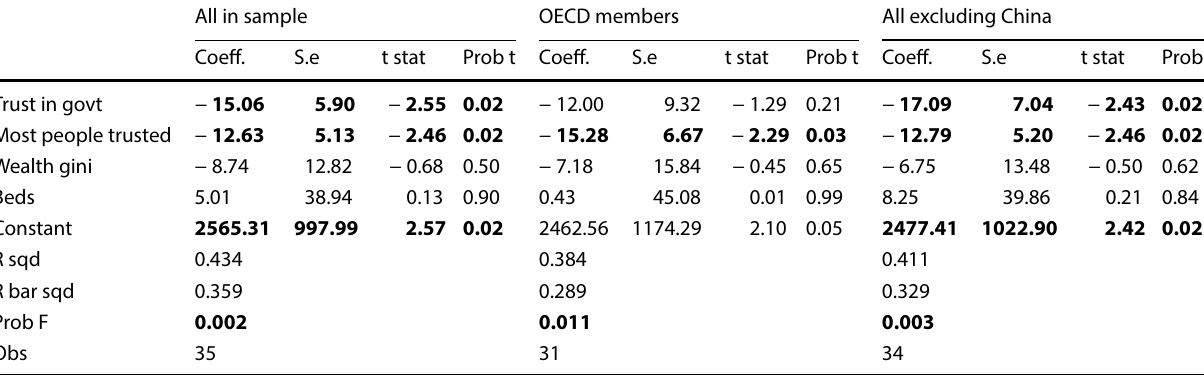
Table 3 Regression results for the second